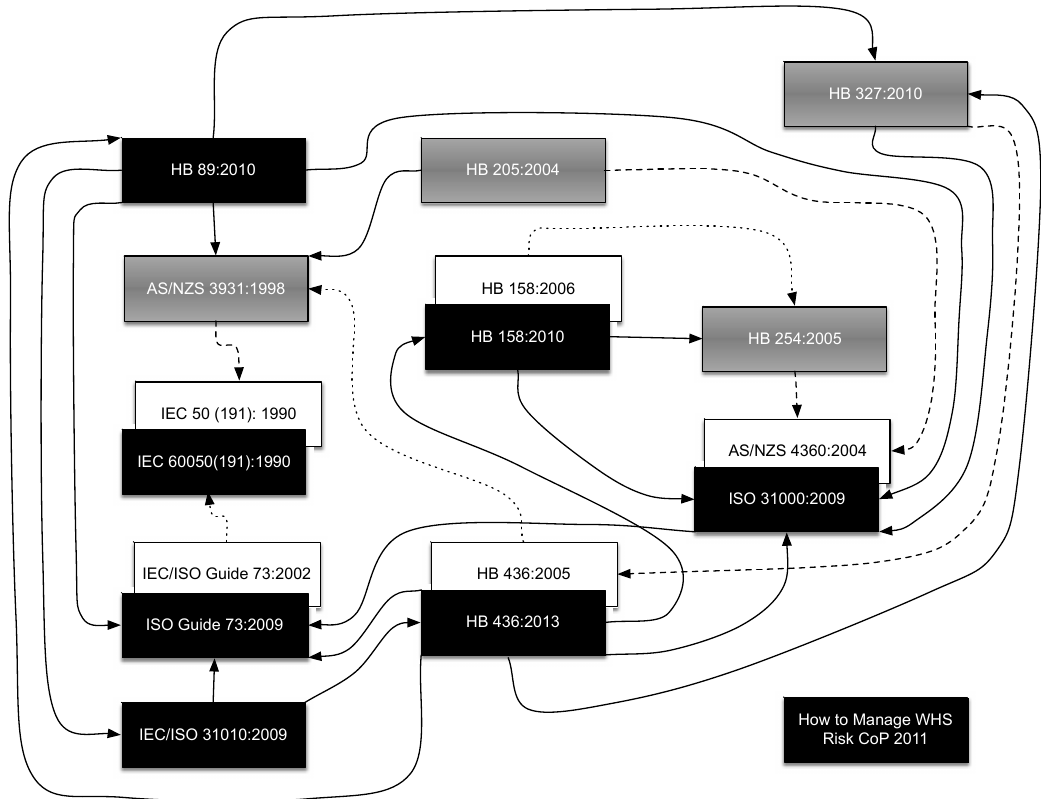
Figure 1. Node ‐ diagram depicting the interrelationships of the chosen standards, handbooks and codes of practice.